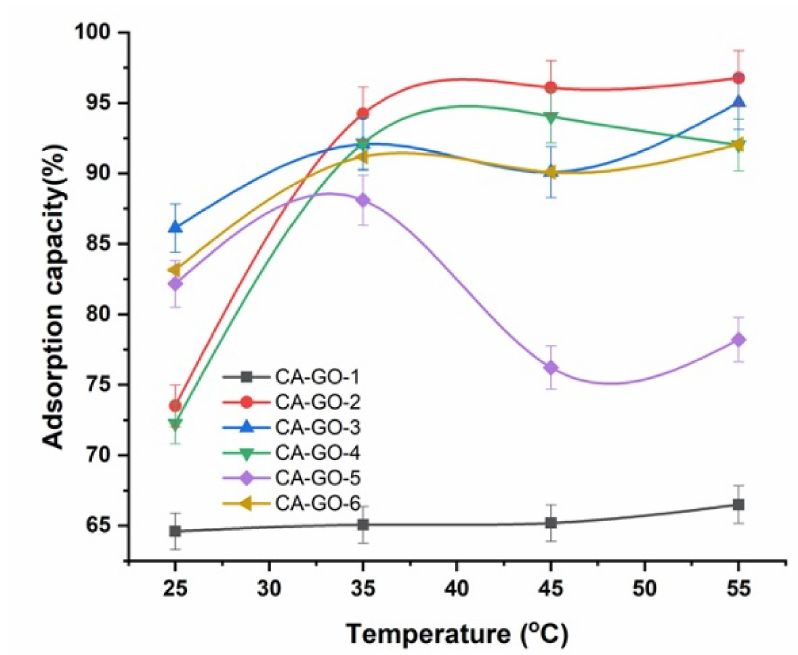
Figure 4. E ff ect of temperature on the adsorption of Ni 2 + onto CA-GO.